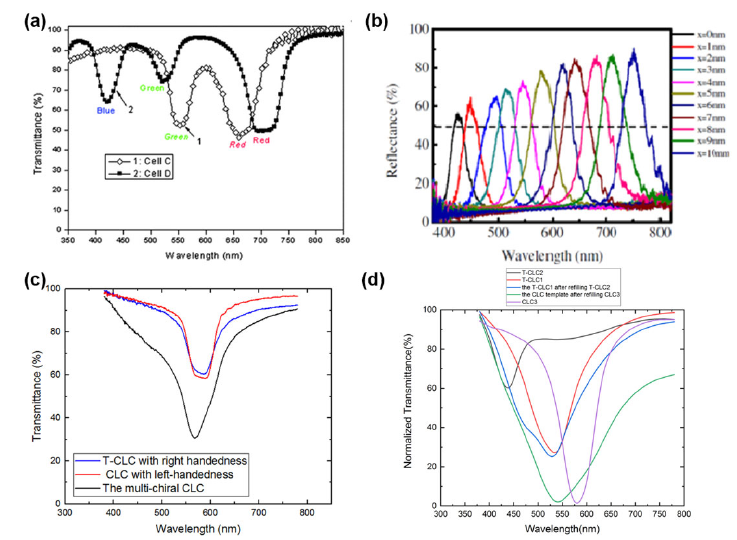
Figure 6. ( a ) The transmission spectra of multiple pitch CLC films; reprinted with permission from Ref. [61]. Copyright 2010 Royal Society of Chemistry. ( b ) Reflection spectra of the spatially-tunable and hyper-reflectivity refilling template sample; reprinted with permission from Ref. [78]. Copyright 2017 SPIE. ( c ) Transmission spectra of high reflectivity CLC filter; Reproduced from Ref. [79]. MDPI, 2021. ( d ) Transmission spectra of wide bandwidth CLC filter. Reproduced from Ref. [80]. MDPI, 2021.